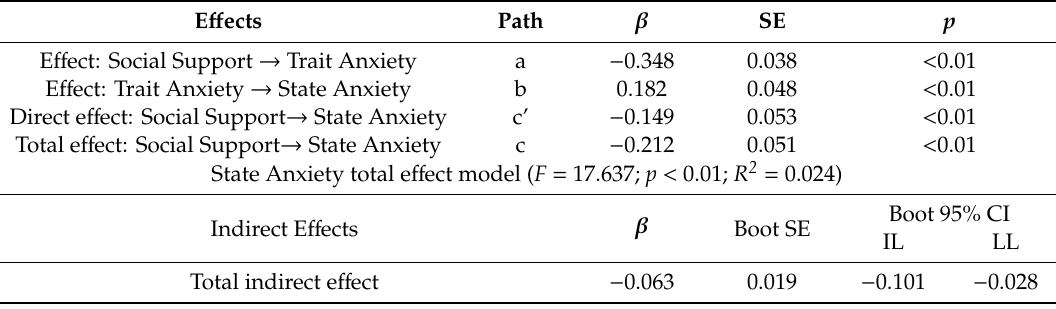
Figure 1. Mediation modeling results. Table 5. Mediation e ff ect test of trait anxiety ( n =